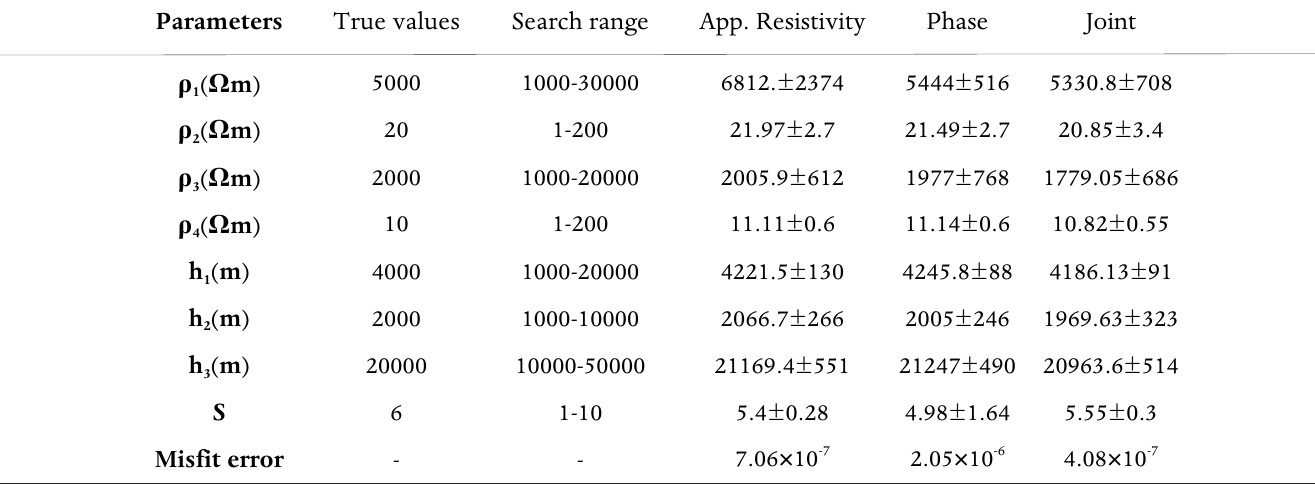
Table 6. Model 3: inversion results with optimization of static shift.